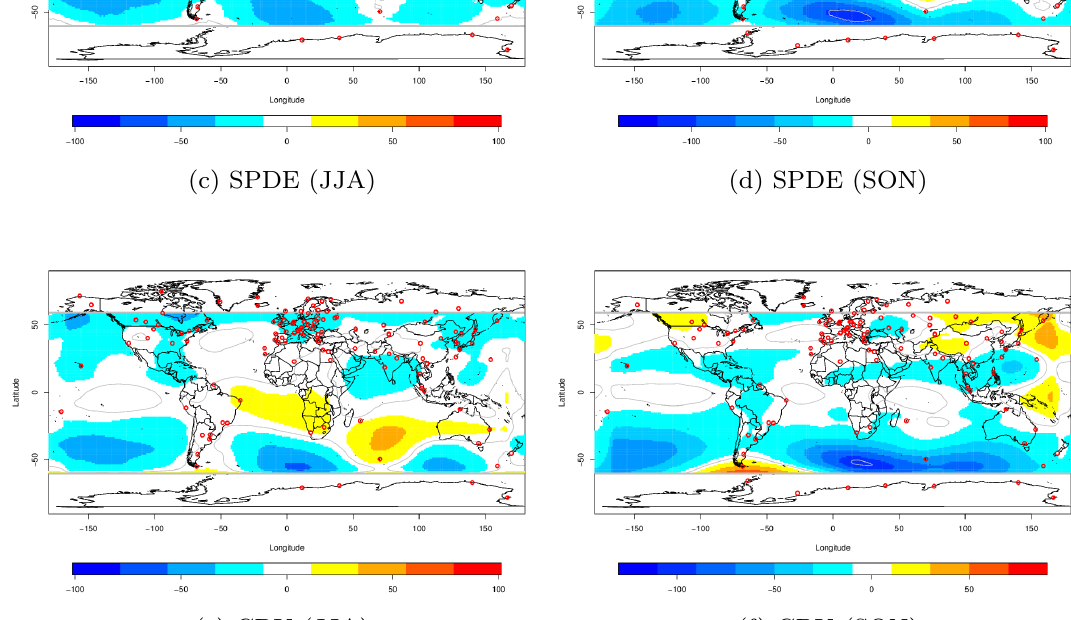
SPDE-based mapping technique instead of covariance-based